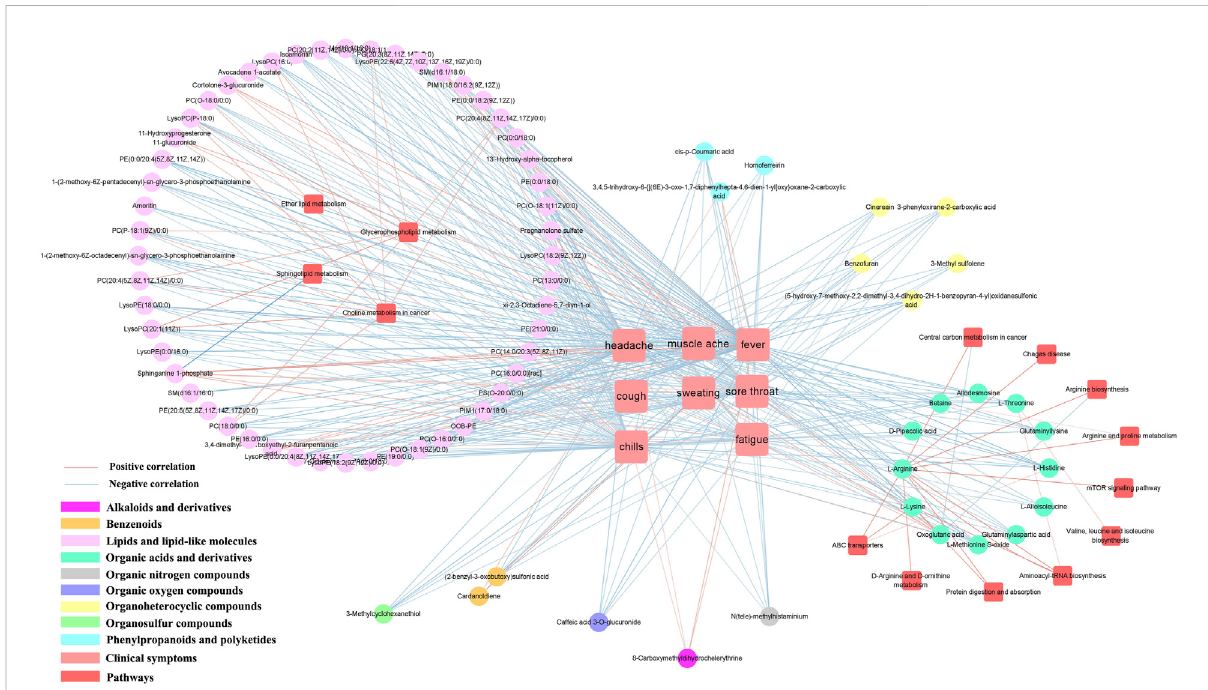
FIGURE 5 Metabolite-clinical symptom correlation in serum samples. Only metabolite correlations with |PCC| ≥ 0.9 and p < 0.001 were